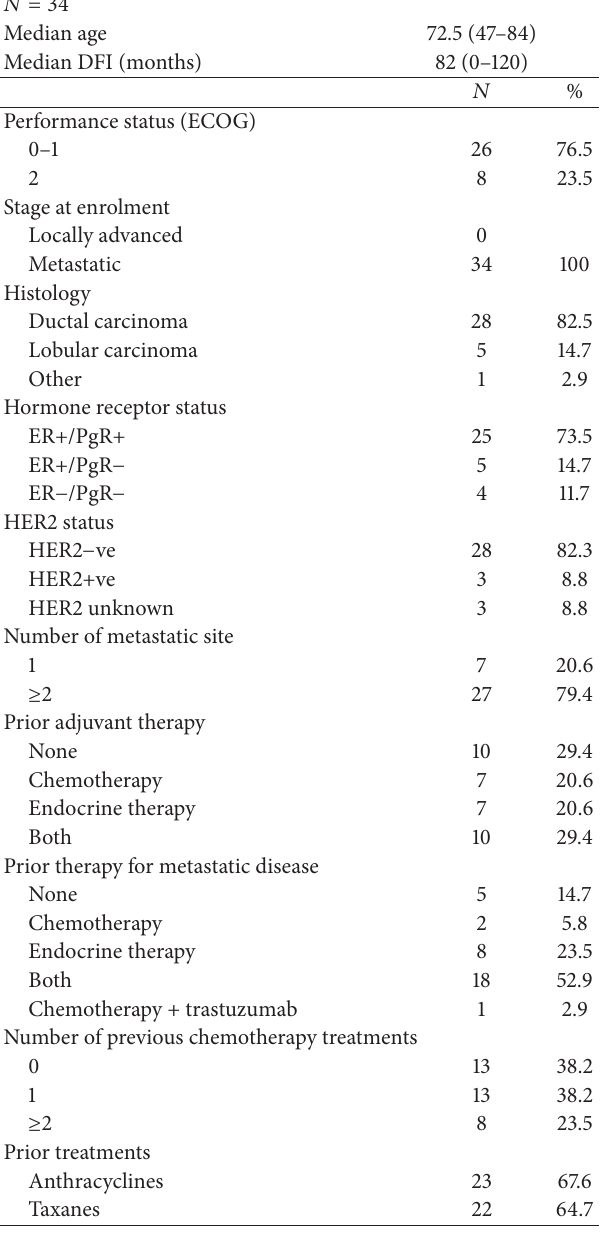
Table 1: Patients’ characteristics, Phases